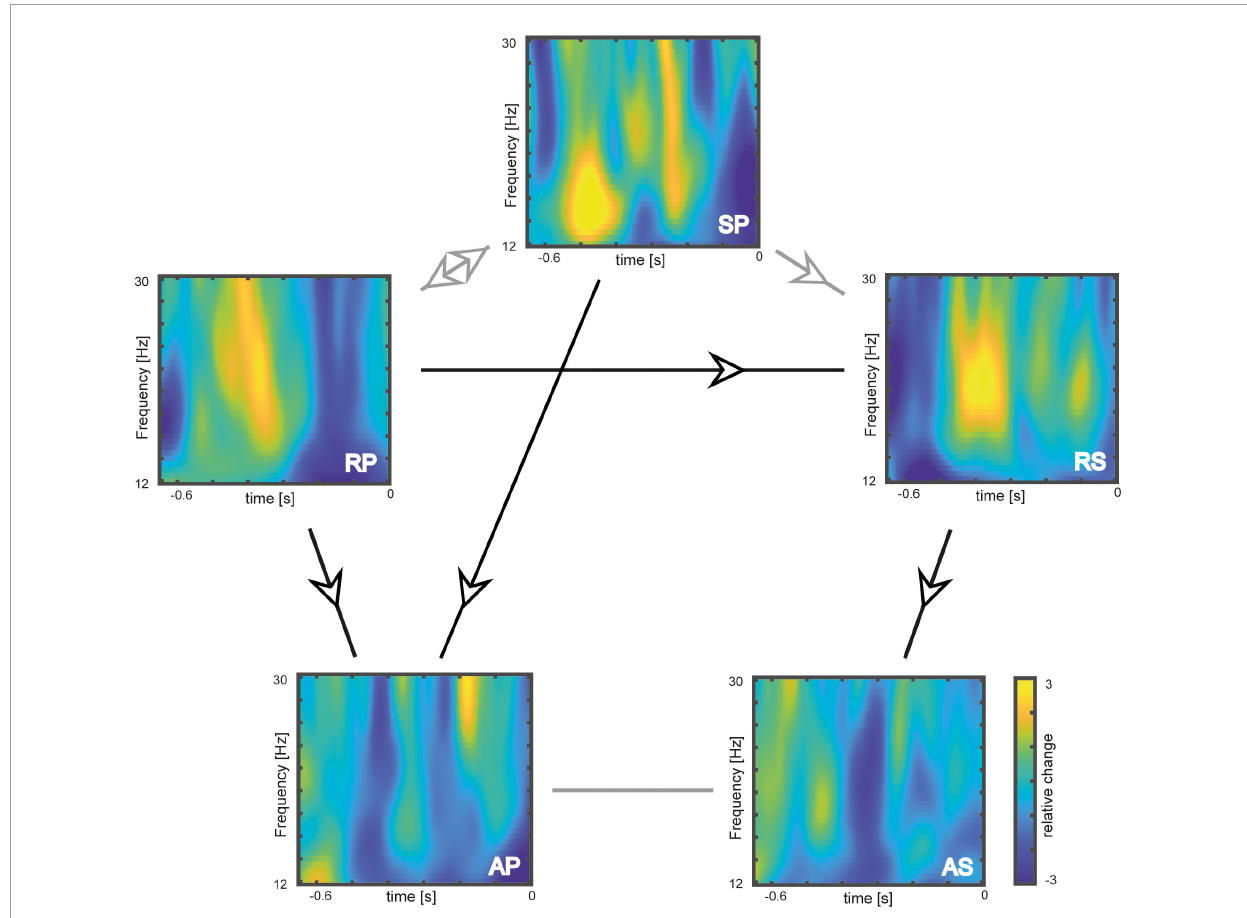
FIGURE1 Single experimental conditions: Pre-stimulus beta power grand average across significant electrodes plotted separately for each experimental condition. Beta power is plotted as relative change from the mean in percent. Arrows and lines indicate the hypotheses-guided computed contrasts. Significant effects are plotted in black, non-significant effects are plotted in gray. RP, rhythmic pedaling; AP, arrythmic pedaling; RS, rhythmic sitting; AS, arrhythmic sitting; SP, self-generated